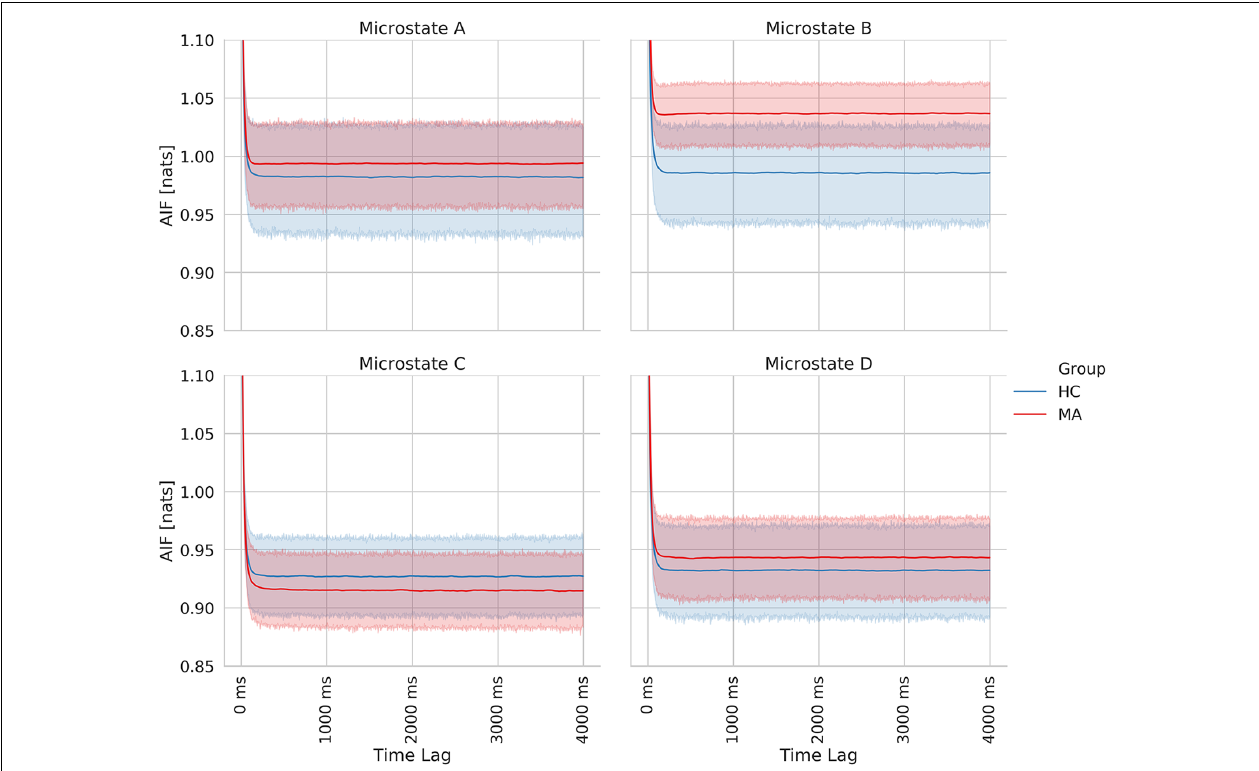
FIGURE 7 | Time-lagged mutual information plots for each class of EEG microstate averaged across subjects of each group. The shaded area represents the 95% confidence for each